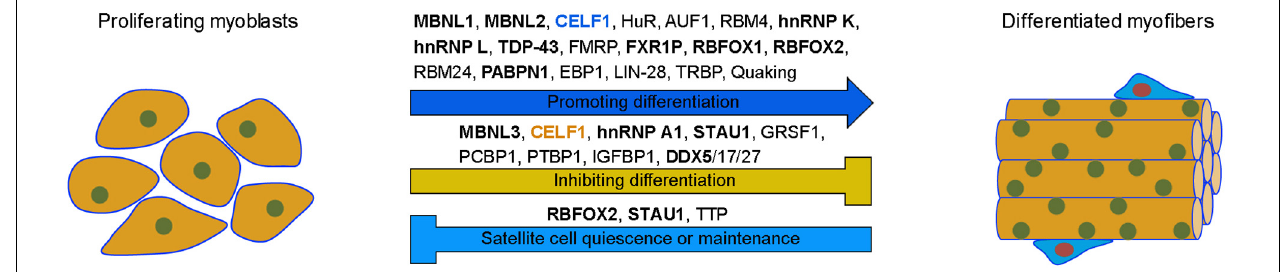
FIGURE 4 | Differential functions of RBPs in myogenesis. Many RBPs promote the differentiation of proliferating myoblasts into functional myofibers, while others either inhibit myogenic differentiation or maintain satellite cell quiescence. Note that cytoplasmic CELF1 (blue) promotes, while nuclear CELF1 (orange) inhibits, muscle differentiation by regulating the stability of myogenic mRNAs or by repressing the inclusion of muscle-specific exons, respectively. RBPs in bold indicate their potential implication in muscle disease, such as MD, FSHD, or